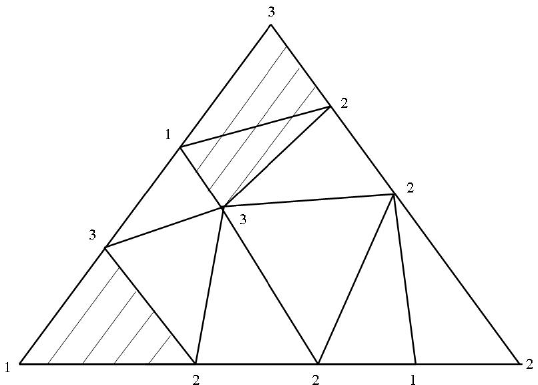
Figure 1. Sperner’s